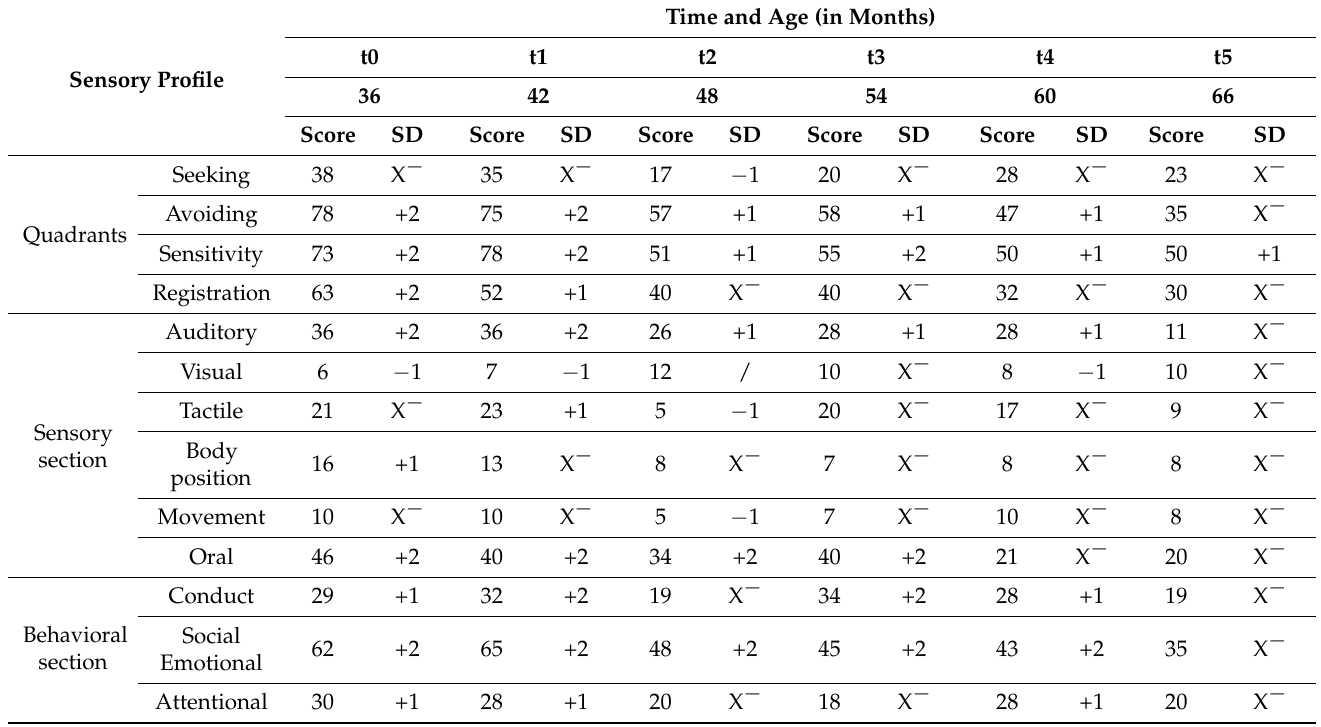
Table 3. Results of the sensory profile 2 in all assessment